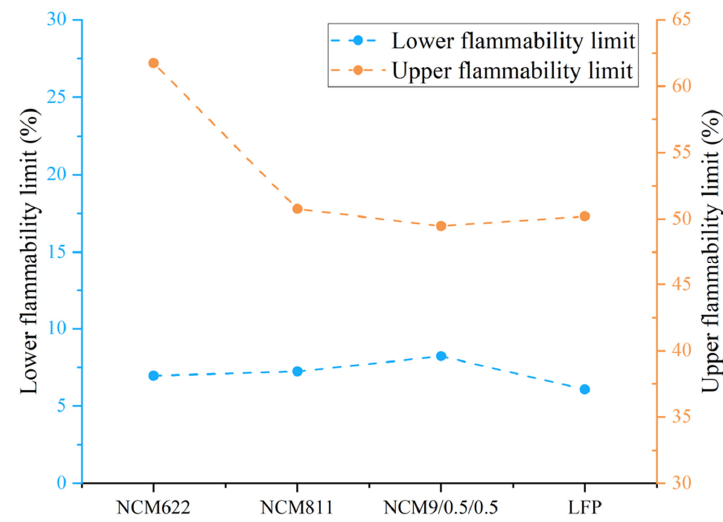
Figure 10. Flammability limit of gas after thermal